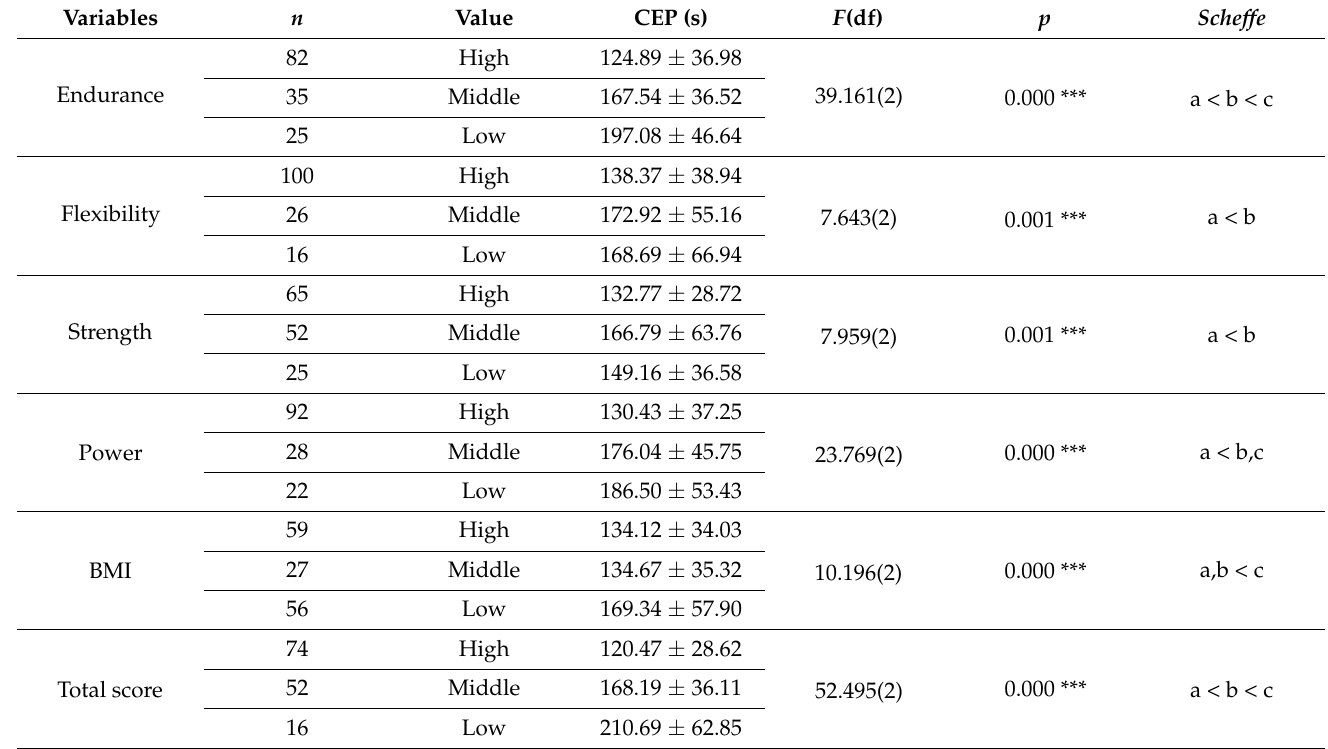
Table 4. Comparison of CEP by PAPS levels (Mean ±